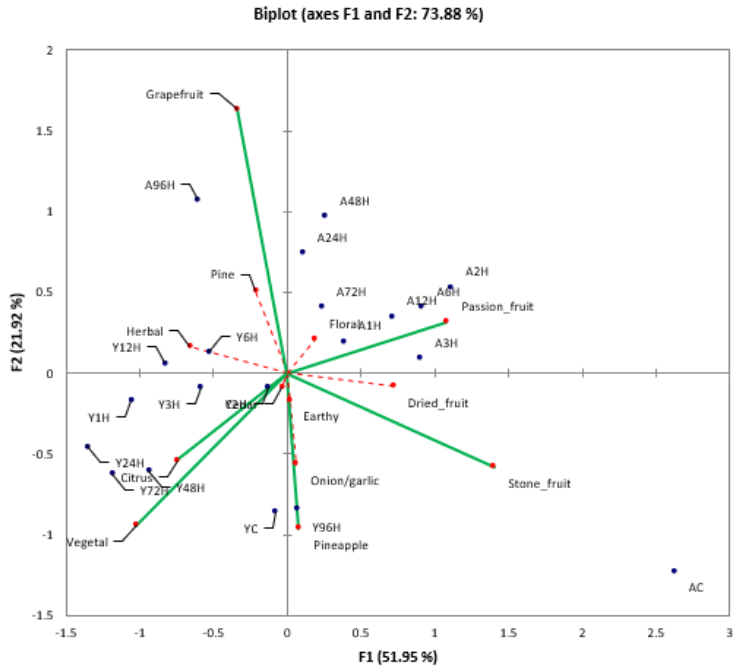
Figure 6. CVA loadings plot of the descriptive analysis ballot attributes and sample treatments. Y = Young, A = Aged ( n = 3).